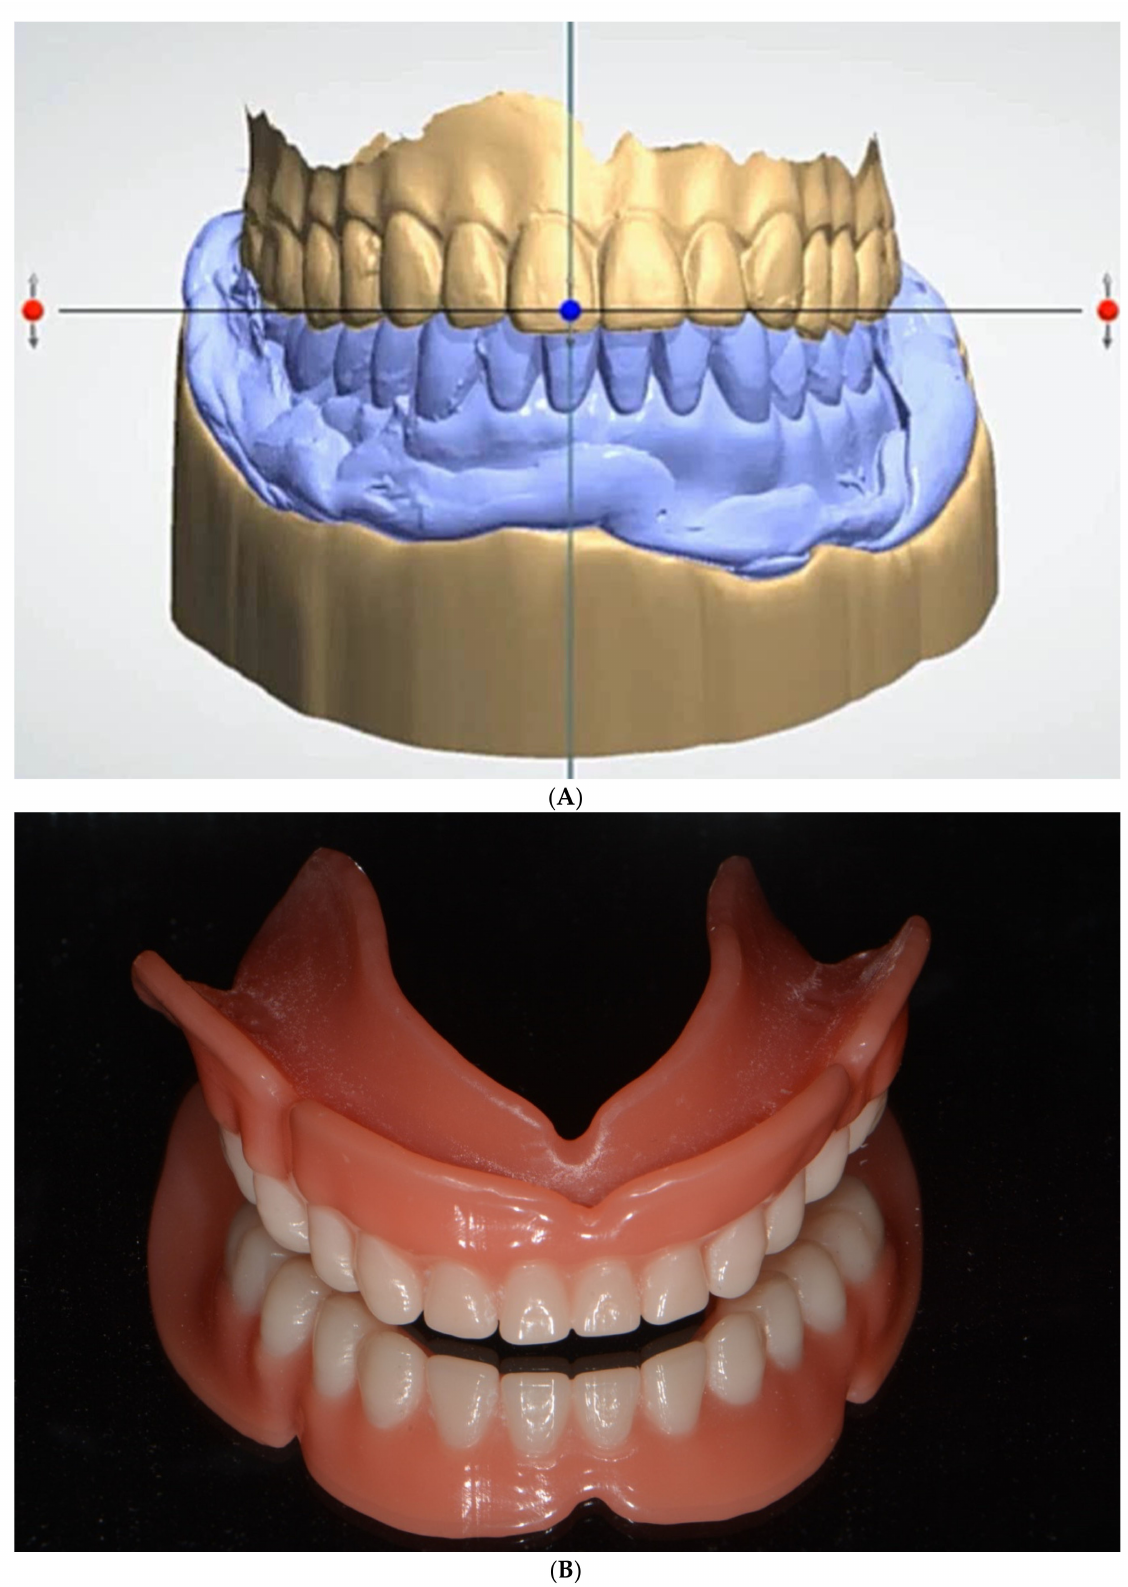
Figure 3. Final denture fabrication. ( A ): Final denture is designed using the digital images of the trial denture obtained by scanning the final impression. ( B ): Printed final